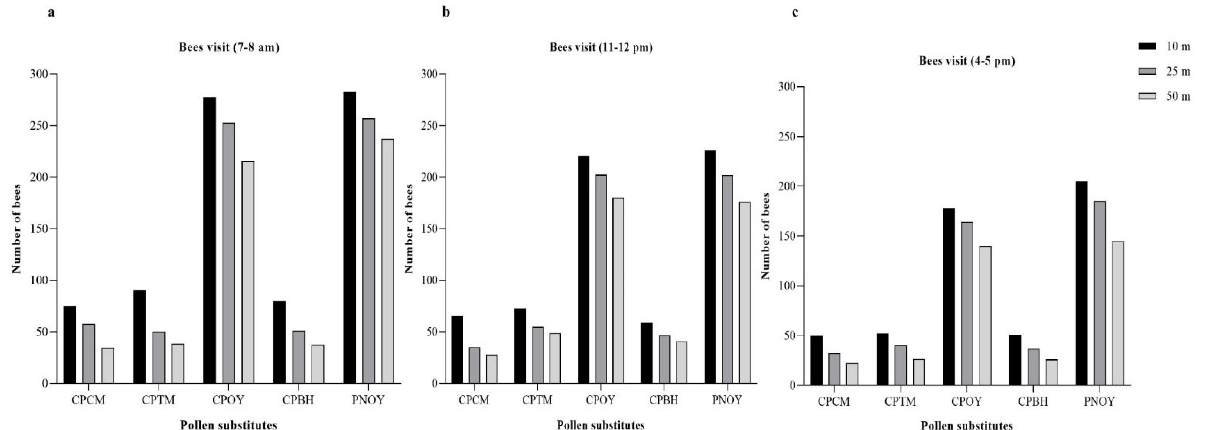
Figure 6. Honey bee visits at different times and pollen substitutes present at different distances: ( a ) 7–8 A.M. time ( b ) 11–12 A.M. time ( c ) 4–5 P.M. time. Whereas, CPCM = Chickpea flour + Cinnamon powder, CPTM = Chickpea flour + Turmeric powder, CPOY = Chickpea flour only, CPBH = Chickpea flour + Both powders, PNOY = Pollen only as a control.